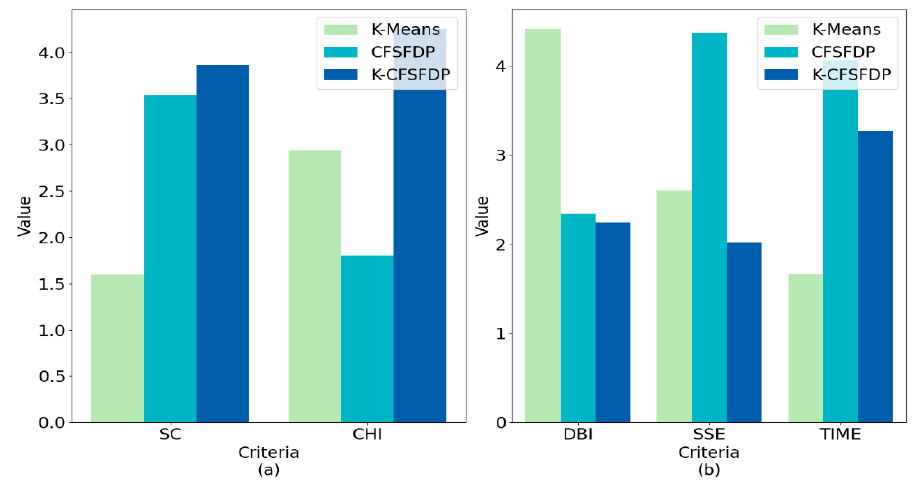
Figure 16. Clustering performances of three models under di ff erent evaluation criteria in dataset S1: ( a ) the higher the value, the better and ( b ) the lower the value, the